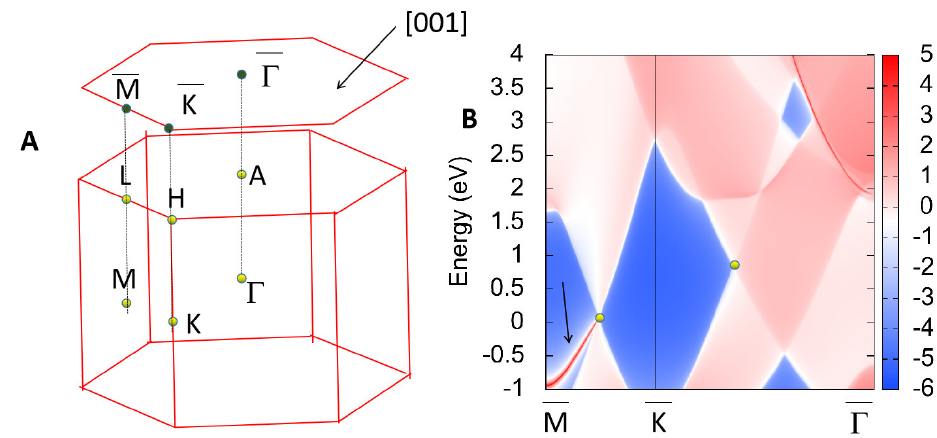
Figure 8. ( A ) The 3D bulk of BZ and the 2D surface of BZ, ( B ) the projected spectrum of the (001) surface of YB 2 . The band crossing points and the nontrivial surface states are highlighted, using yellow balls and red lines, respectively.